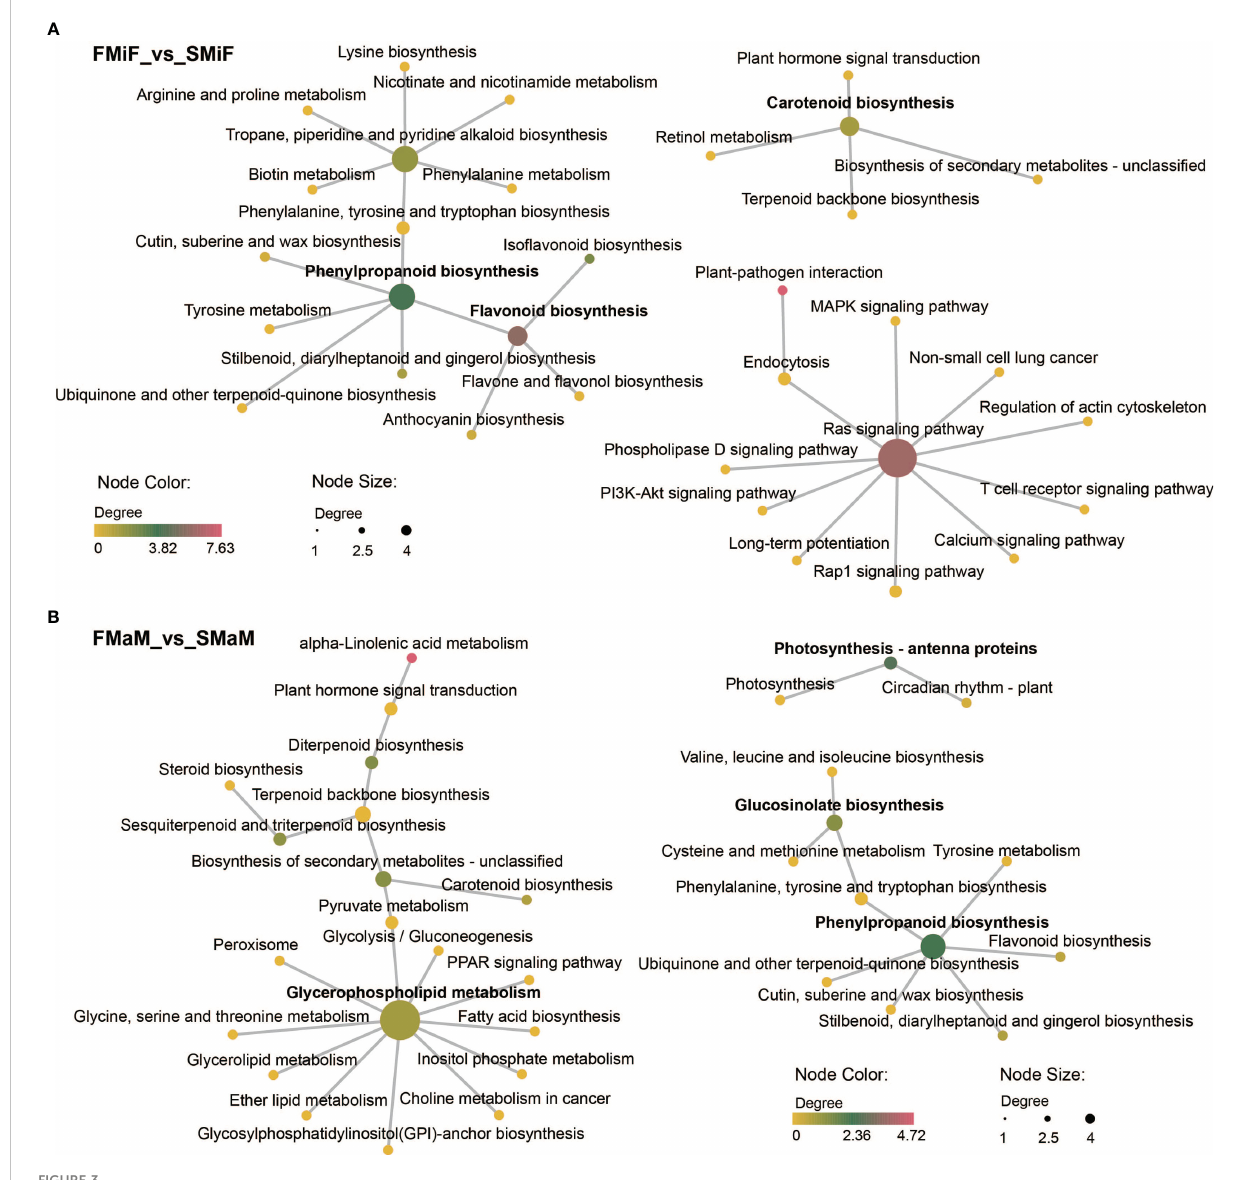
FIGURE 3 KEGG core pathway relationships. (A) KEGG network diagram between FMiF_vs_SMiF. (B) KEGG network diagram between FMaM_vs_SMaM. Different nodes indicate the KEGG pathway, and the colour and size of the nodes indicate the degree of KEGG enrichment. The section in bold represents the core KEGG